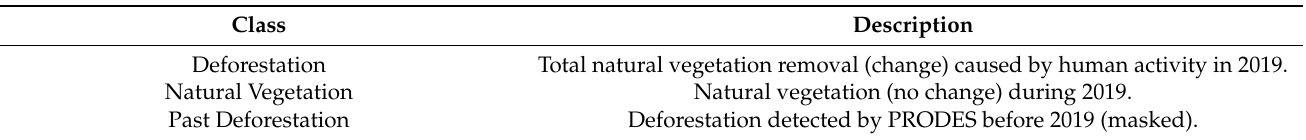
Table 3. Mapping classes in deforestation detection.